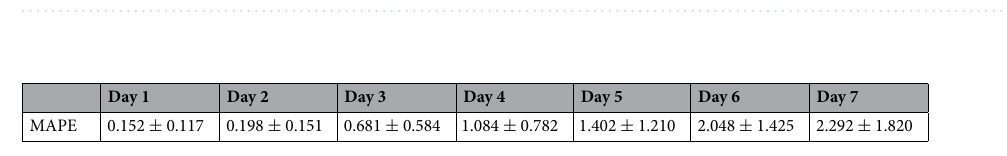
Figure 3. The comparison of tumor cell density values for ground truths and predictions through time steps 0 to 7 for the example case. The tumor cell density at time step 0 corresponds to the tumor cell density of input. (The application of the antiangiogenic drug is at the end of time steps 0, 2, 4, 6 and chemotherapy drug is at the end of time steps 2, 4, 6.)